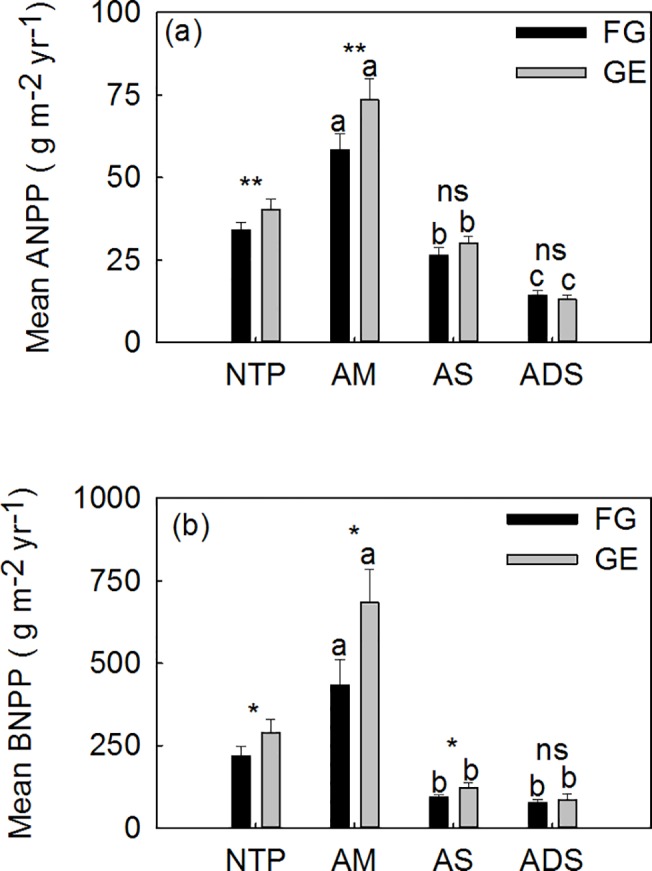
Multiple comparisons of the mean values of above- and below-ground net primary productivity (ANPP and BNPP).A two-way analysis of ANOVA with Turkey’s test was applied to free grazed (FG) and grazed excluded (GE) sites, to determine if ANPP (or BNPP) is significantly different among the three zonal alpine grassland types (AGTs) on the Northern Tibetan Plateau, AM = alpine meadow; AS = alpine steppe; ADS = alpine desert-steppe. Different letters indicate statistically significant differences at P < 0.05. Paired samples t-tests were conducted to determine if grazing exclusion altered the ANPP and BNPP relative to the adjacent open pastures under livestock grazing. ** and * indicate significant differences at P < 0.01 and P < 0.05, respectively. The ns means no significance in statistics.